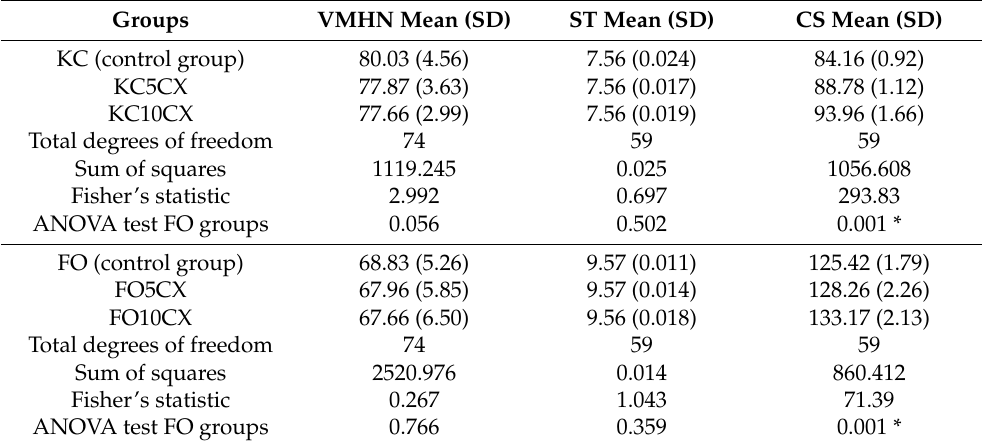
Table 3. Comparison of mechanical properties from experimental and control groups.